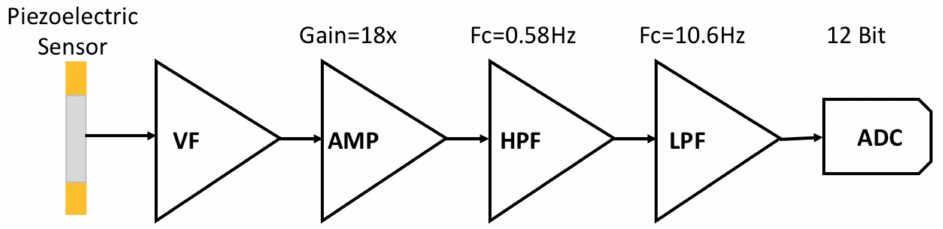
Figure 4. Processing of piezoelectric signals from piezoelectric ceramics by various amplifiers of the AFE.